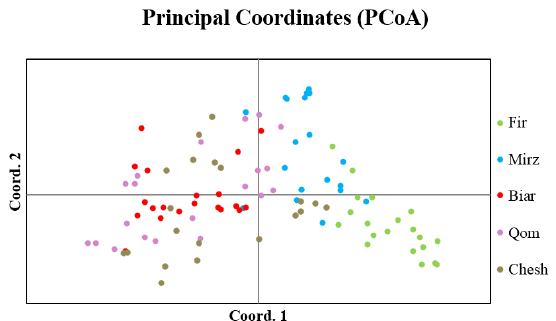
Fig. 6. A two-dimensional plot of the Principal Coordinate Analysis (PCoA) of ISSR data showing the clustering of populations of L. undulata